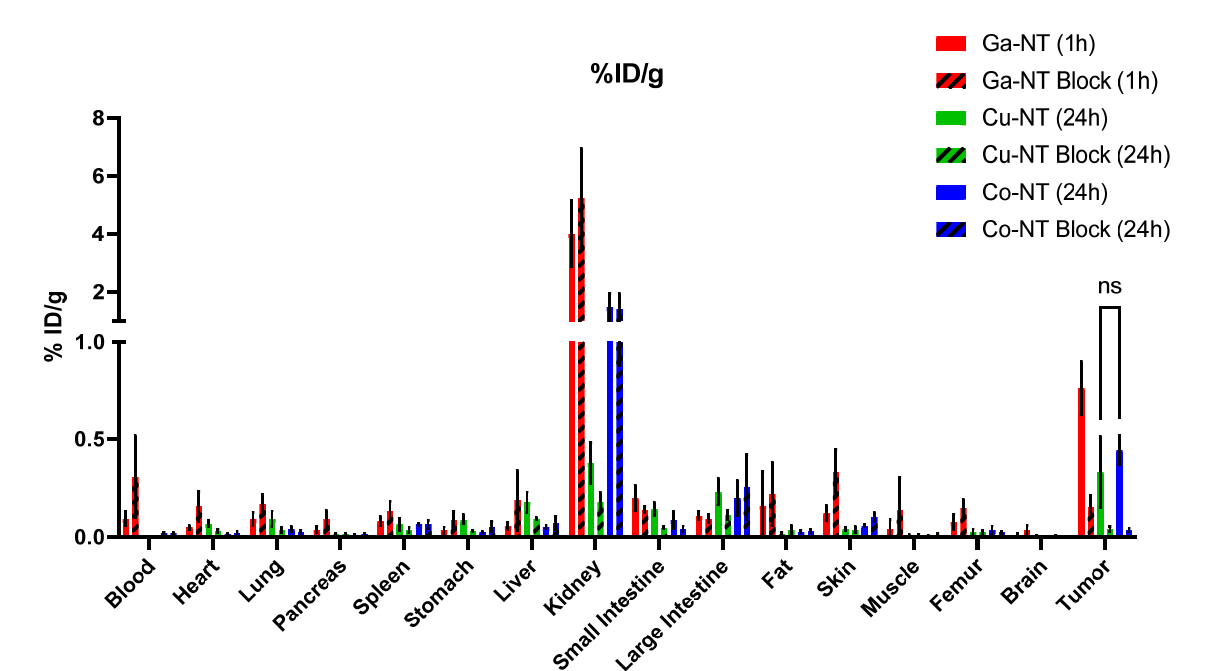
Figure 7. Biodistribution data were calculated after the last imaging timepoint. Organs for the [ 68 Ga] Ga-NOTA-NTS-20.3 biodistribution were collected after the 1 h imaging timepoint, whereas for [ 64 Cu] Cu-NOTA-NTS-20.3 and [ 55 Co] Co-NOTA-NTS-20.3, tissues were collected after the 24 h im-